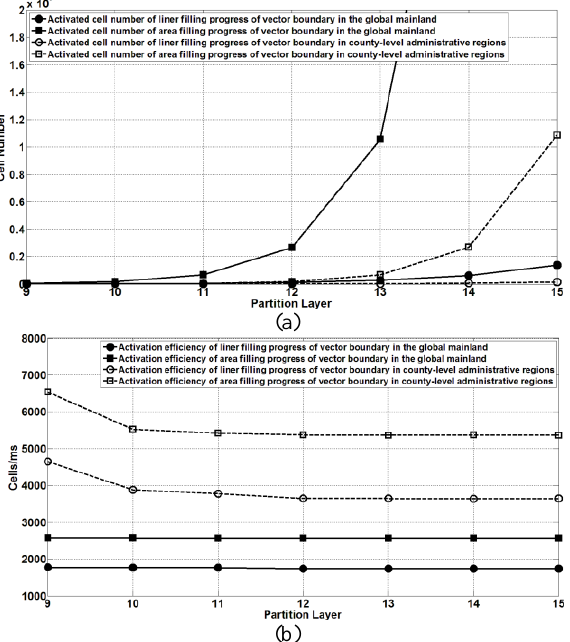
Figure 8. Activated cell number and activation efficiency of vector data of different layers and types in the display process of DGGS. (a) Comparison of activated cell number; (b) Comparison of activated cell